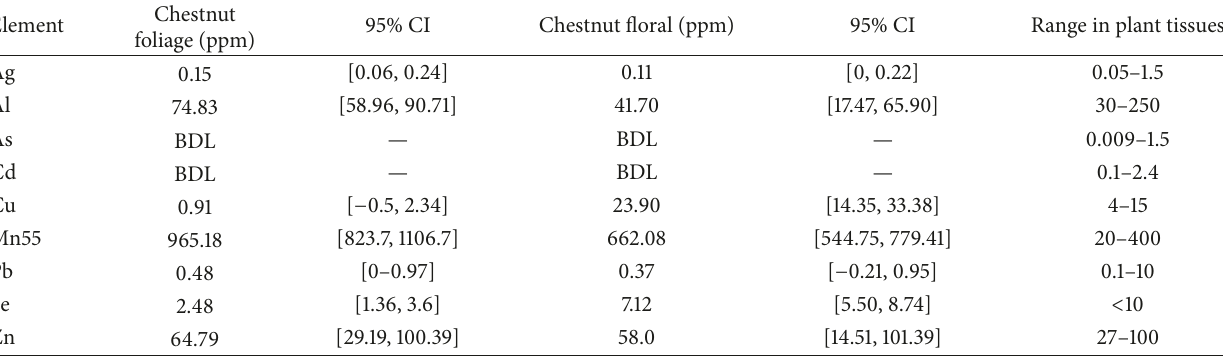
Table 6: Mean concentrations of metals in foliage and floral tissue of chestnuts (pure American, BC 1 F 3 , and BC 2 F 3 ) growing in the Tri-Valley Research Site as compared with ranges of metals in plant tissue (ppm) as reported in the literature [45–49]. BDL = below detection limit.